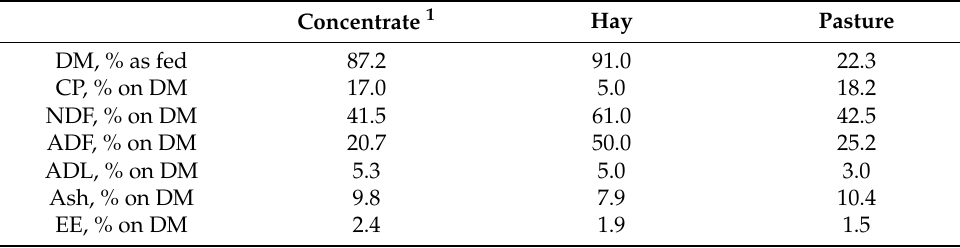
Table 1. Chemical composition of feeds offered to nursing ewes. Concentrate 1 Hay Pasture DM, % as